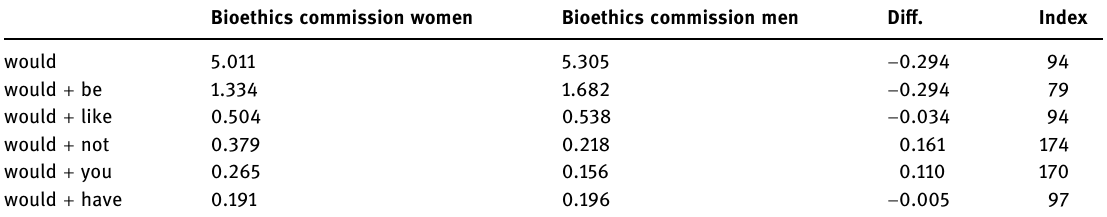
Bioethics commission